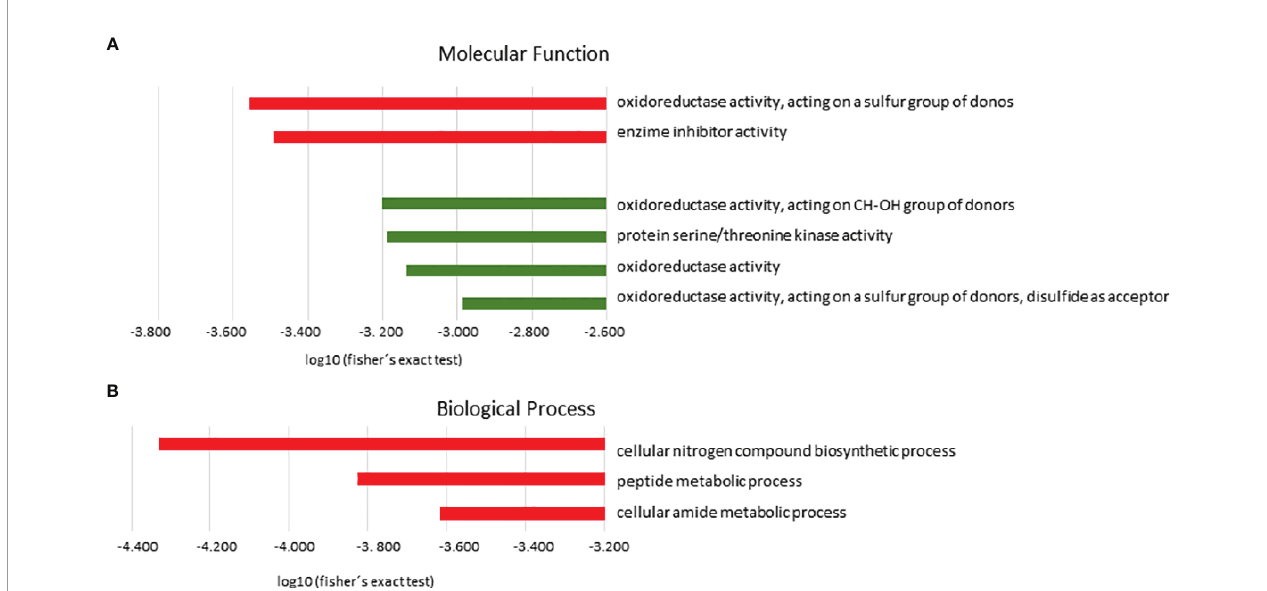
FIGURE 2 | Gene ontology enrichment analysis (GO). Protein distribution based on molecular functions (A) and biological processes (B) predicted in L. braziliensis from the atypical lesions group in relation to the typical lesions group. In red, categories enriched in the upregulated proteins group; in green, categories enriched in the downregulated proteins group. Terms overrepresented by P < 0.05 in Fisher ’ s exact test, fi ltering for FDR <